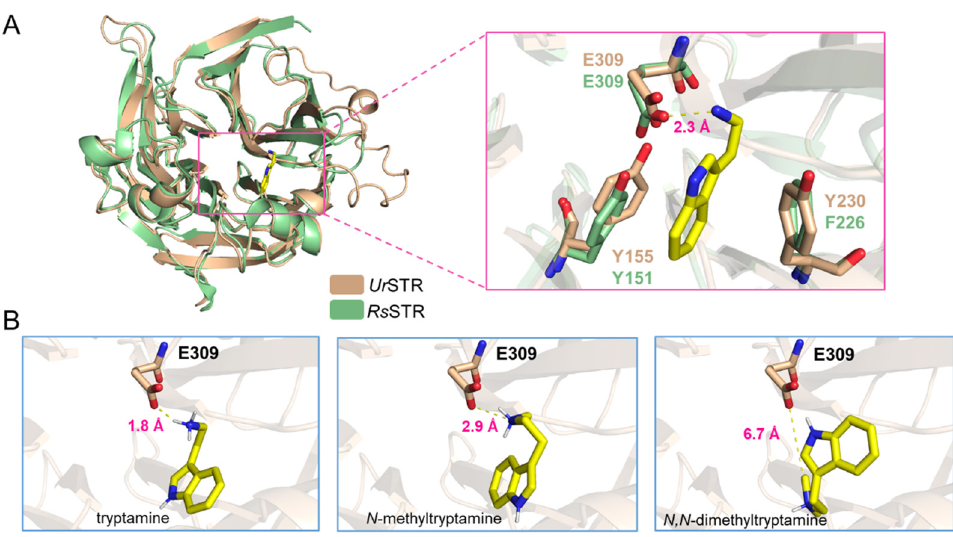
Figure 8. Docking results for tryptamine and analogues. ( A ) the structure of Ur STR in wheat and Rs STR in pale green and tryptamine in the active pocket. ( B ) the distance between the substrate (tryptamine, N-methyltryptamine and N,N-dimethyltryptamine) and the catalytic residue Glu309 (E309).